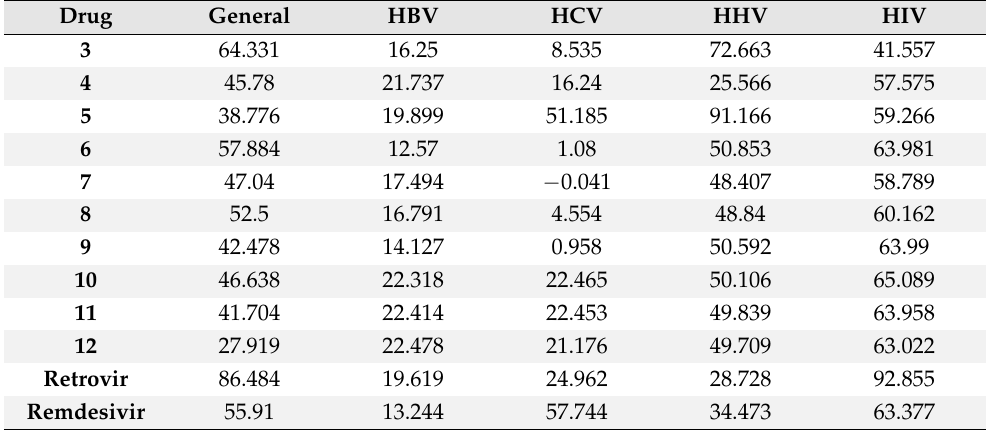
Table 2. Predicted antiviral activities of 3 – 12 (% inhibition).